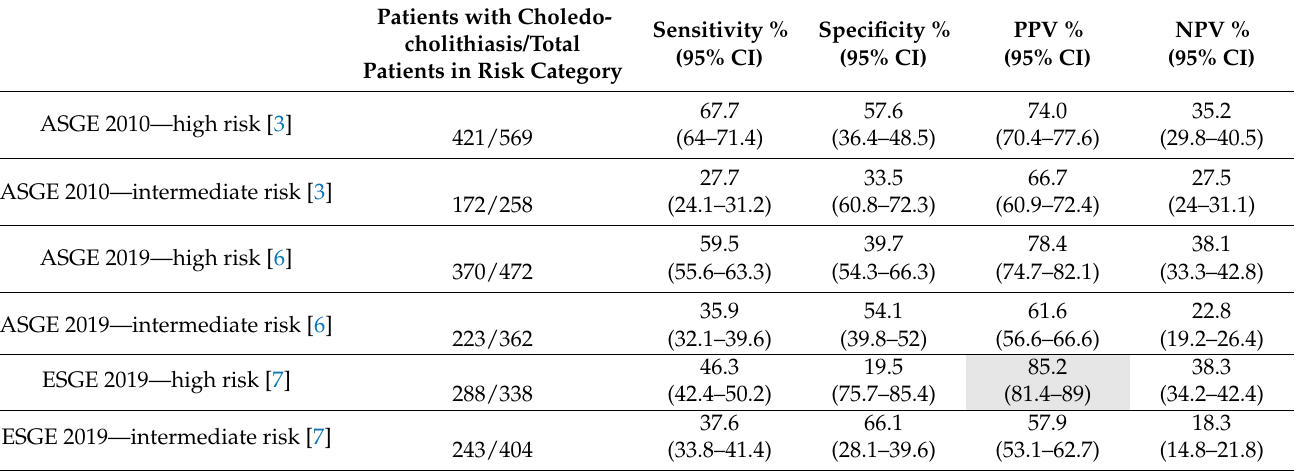
Table 5. Performance characteristics of endoscopy-society choledocholithiasis guidelines when applied to the study cohort.